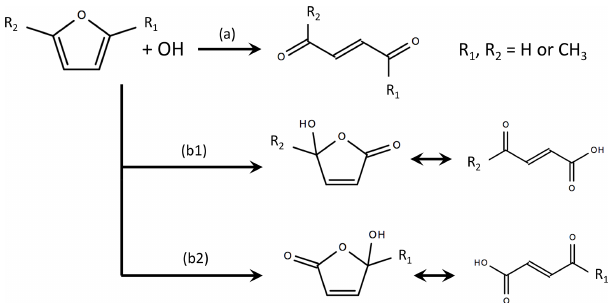
Figure 5. Summary of OH oxidation pathways and final prod- ucts for furan, 2-methylfuran, and 2,5-dimethylfuran, where branch (a) is the substituent-retention pathway, and branches (b1) and (b2) are substituent-loss pathways (adapted from Aschmann et al., 2014). In this study, the branching ratios are assumed to be [0.7 a , 0.3 b1 ] for furan, [0.31 a , 0.39 b1 , 0.31 b2 ] for 2- methylfuran, and [0.27 a , 0.73 b1 ] for 2,5-dimethylfuran. Details of the assumed RO 2 reaction schemes are provided in Figs.